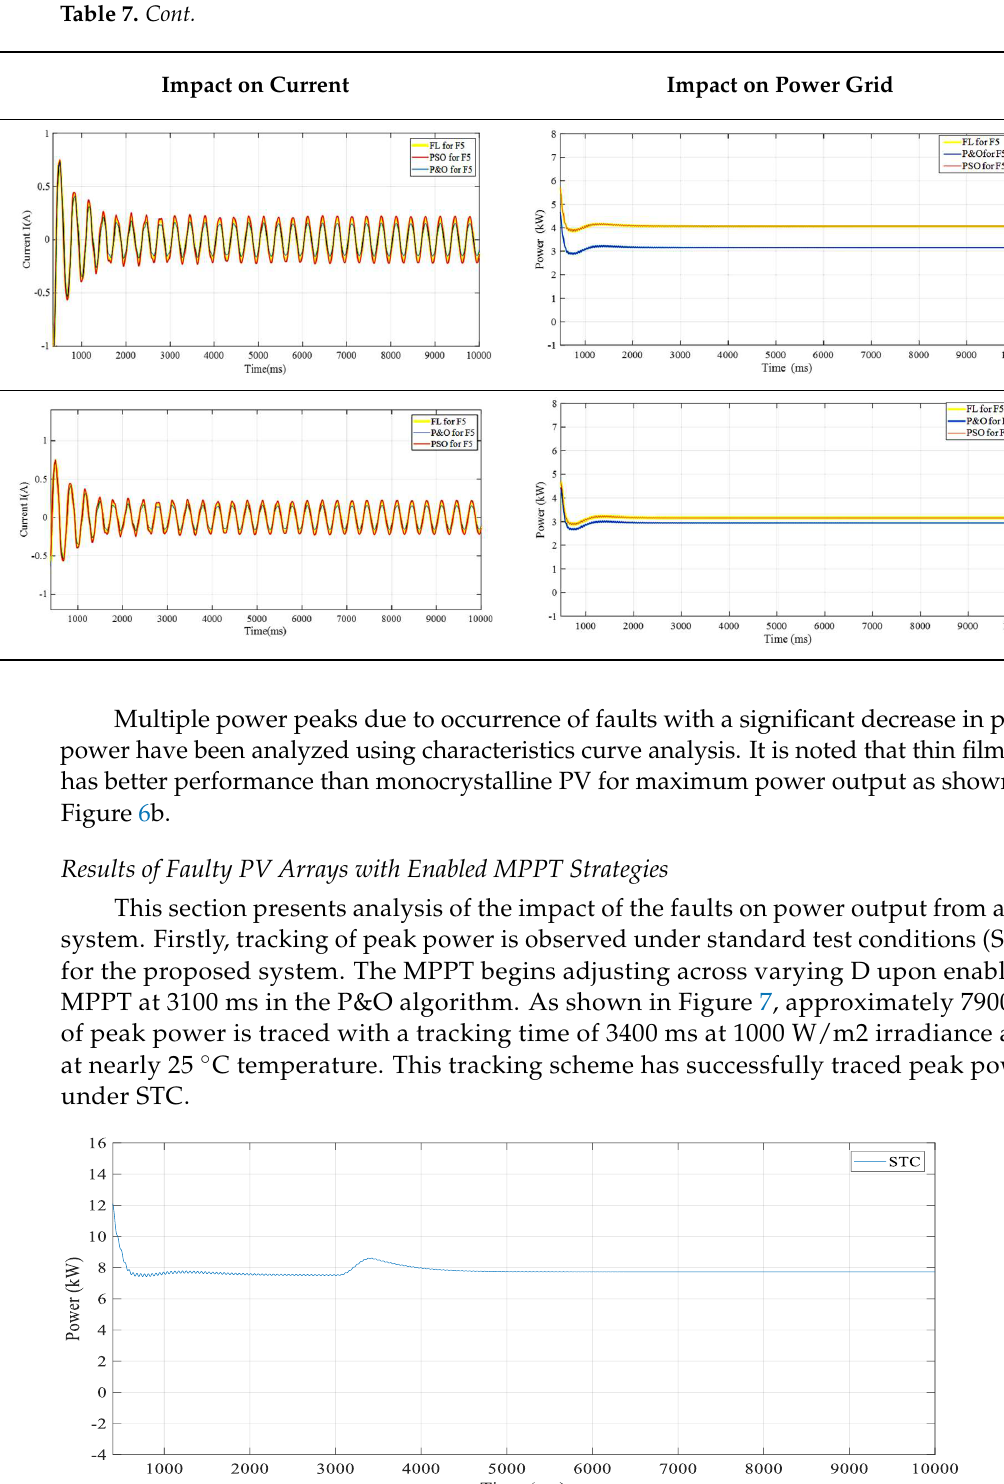
Figure 7. Power under STC (1000 W/m 2 and 25 °C).